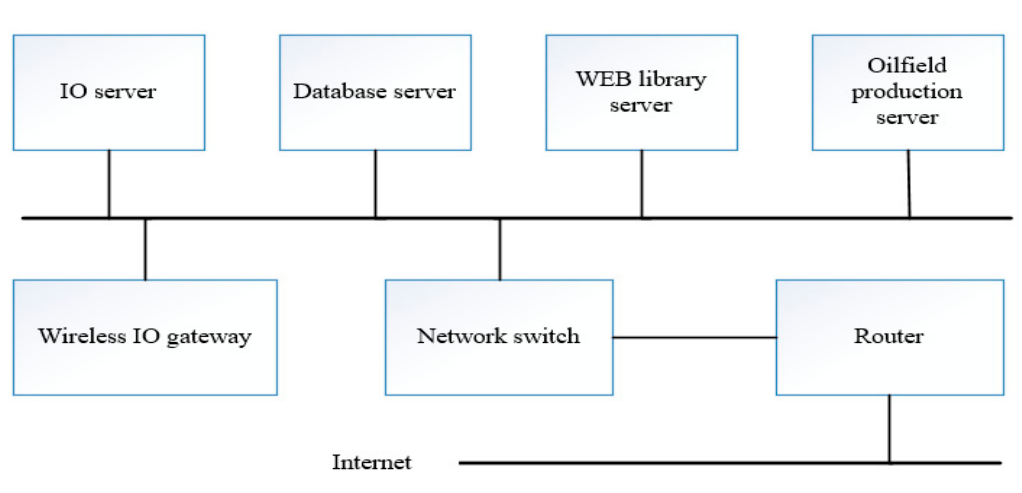
Figure 6. Block diagram of the main node of the scheduling and control center.